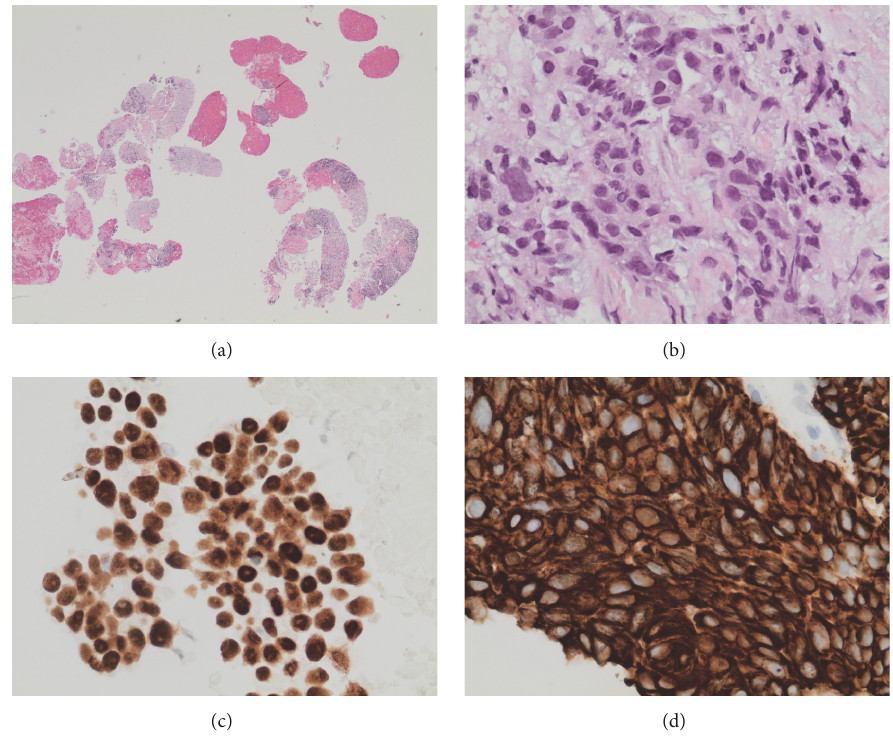
Figure 4: (a) Hematoxylin and eosin staining of a specimen obtained from pancreatic mass with EUS-guided fine needle biopsy. (b) Biopsy fragments show invasive carcinoma morphologically similar to the carcinoma identified in the supraclavicular lymph node and the mediastinal mass. (c and d) Immunostains show that the neoplastic cells express p63 (c) and CK 5/6